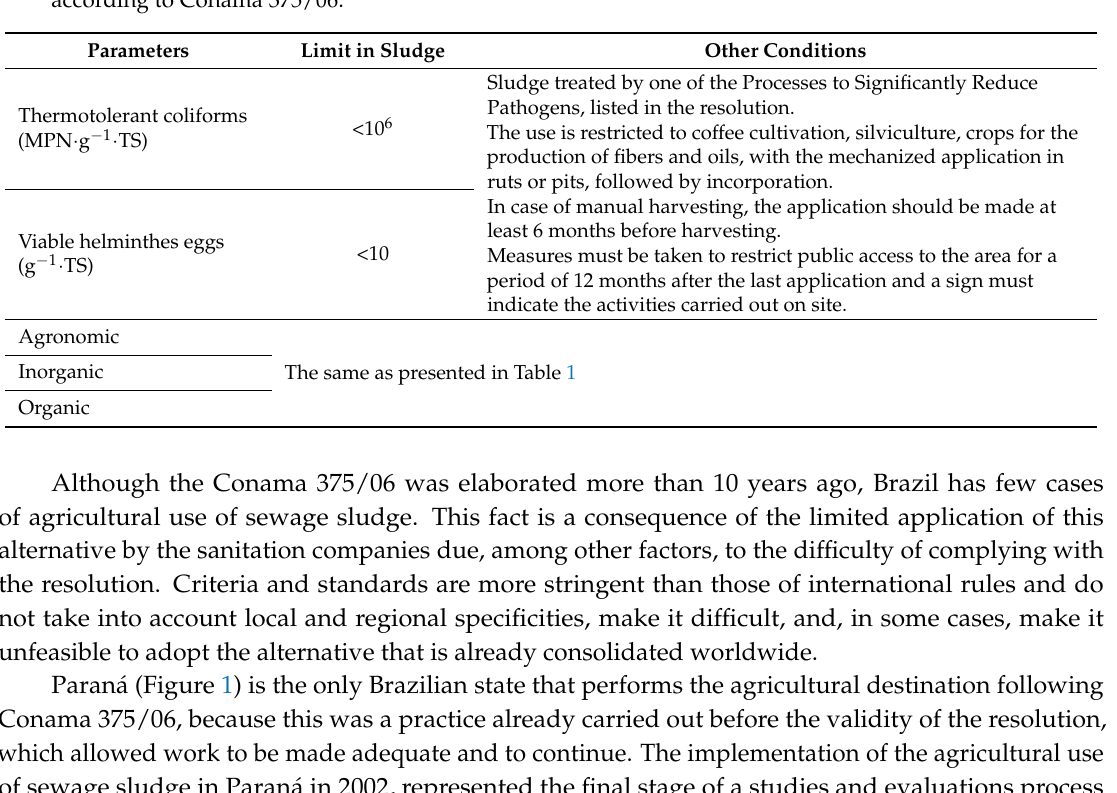
Table 2. Requirements for Class B sewage sludge for agricultural use (allowed until the year 2011), according to Conama 375/06.